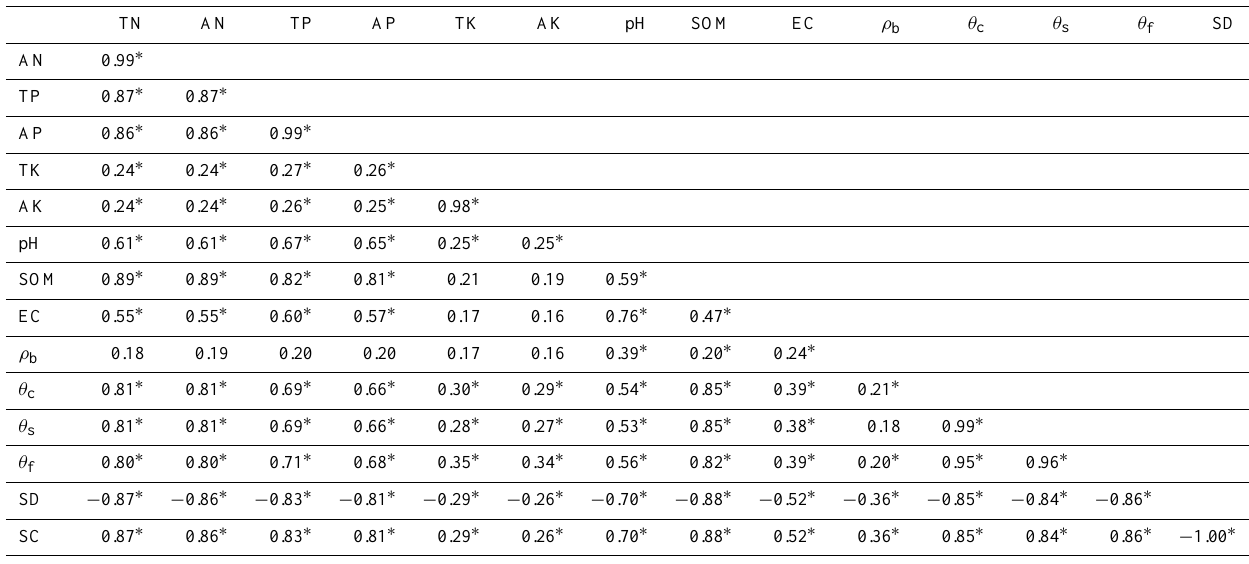
Table 4. Pearson correlations among the soil physicochemical properties. 1